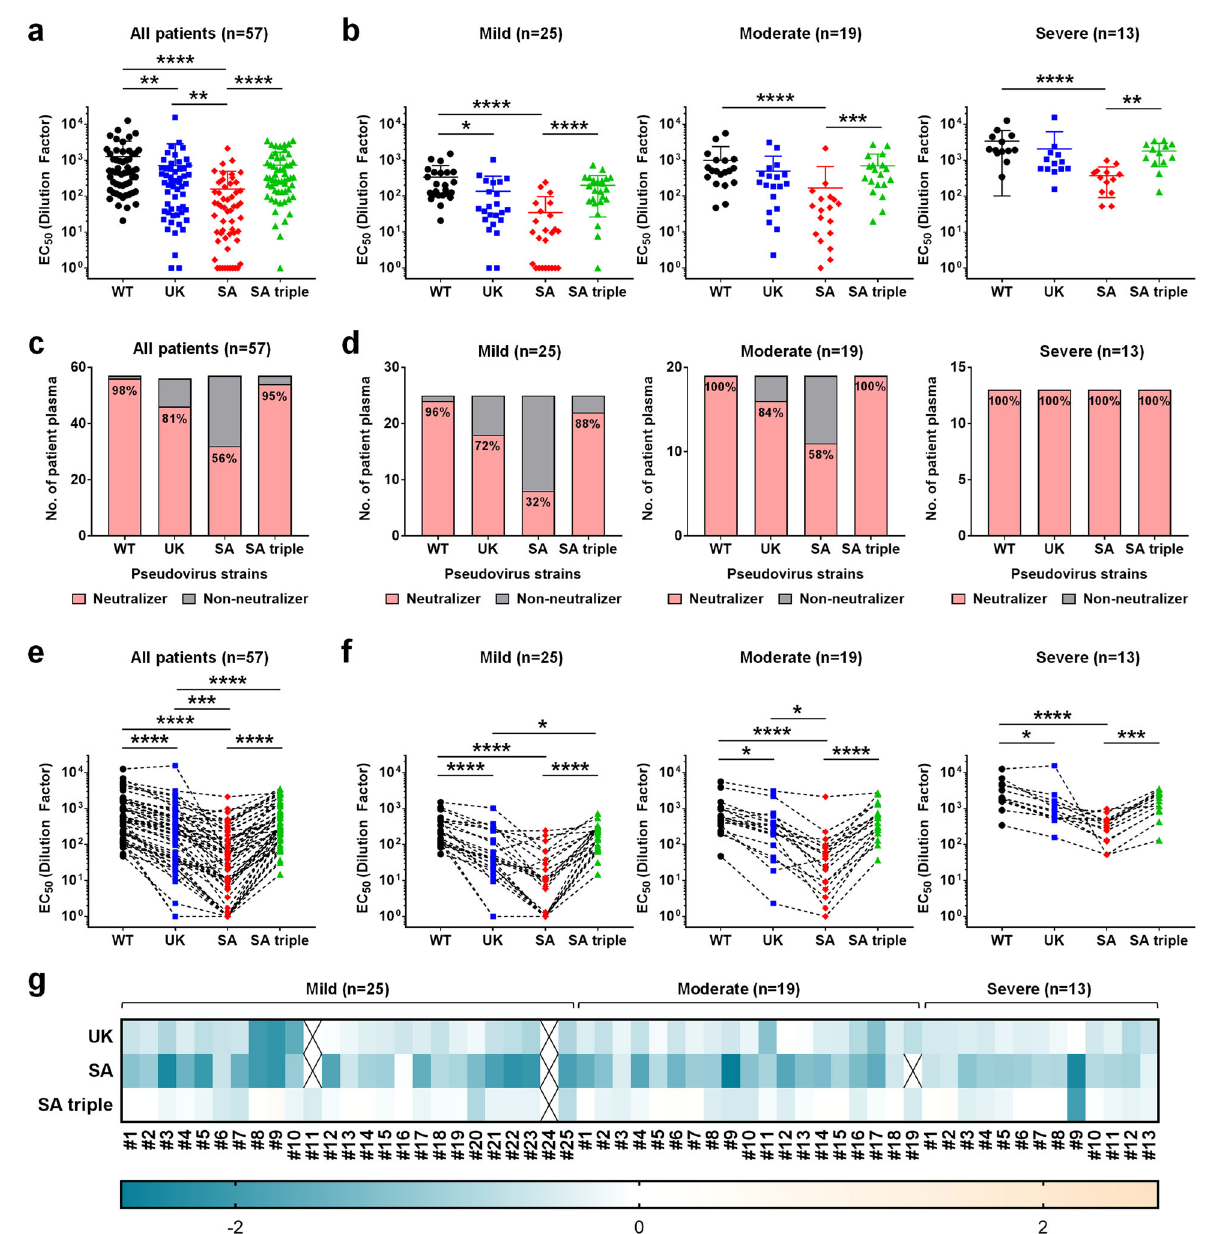
Fig. 2 Pseudovirus neutralization pro fi les of 57 COVID-19 convalescent plasma samples. Anti-SARS-CoV-2 neutralizing antibodies from 57 COVID-19 patients during the SARS-CoV-2 outbreak in Singapore were assessed using pseudovirus expressing SARS-CoV-2 Spike glycoprotein of either the original Wuhan strain (WT), UK strain B.1.1.7 (UK), SA strain B.1.351 (SA), and SA triple mutant K417N/E484K/N501Y (SA triple). All EC 50 values of neutralization were calculated by variable slope four-parameter nonlinear regression model using Graphpad PRISM 7 Software with top and bottom constraints set at 100 and 0% respectively. a , b Dot plots of EC 50 values of neutralization against WT (black circles), UK (blue squares), SA (red diamonds), and SA triple (green triangles) pseudoviruses from all 57 COVID-19 patients ( a ) or presented in three different severity groups of mild ( n = 25), moderate ( n = 19), and severe ( n = 13) ( b ). Statistical analysis was carried out to compare any two different pseudoviruses using Kruskal – Wallis tests followed by post hoc Dunn ’ s multiple comparisons tests (* P ≤ 0.05, ** P ≤ 0.01, *** P ≤ 0.001, **** P ≤ 0.0001). c , d Each individual patient sample was arbitrarily de fi ned as a “ Neutralizer ” (pink bar) if the neutralizing EC 50 is equal to or bigger than 20 (dilution factor) or “ Non-neutralizer ” (gray bar) if the neutralizing EC 50 is less than 20 (dilution factor). The numbers indicate the percentage of neutralizers. Distributions of “ Neutralizers ” and “ Non-neutralizers ” were presented across all 57 patients ( c ) or in each different disease severity groups ( d ). e , f Paired analysis of EC 50 values of neutralization was carried out using Friedman test followed by post hoc Dunn ’ s multiple comparisons tests (* P ≤ 0.05, *** P ≤ 0.001, **** P ≤ 0.0001). Comparison between WT (black circles), UK (blue squares), SA (red diamonds), and SA triple (green triangles) pseudoviruses from all 57 COVID-19 patients ( e ) or presented in three different severity groups of mild ( n = 25), moderate ( n = 19), and severe ( n = 13) ( f ). g Log 10 values of fold increase (positive value) or fold decrease (negative value) in neutralization EC 50 of UK, SA, and SA triple pseudoviruses, relative to the WT pseudovirus are presented as heat maps with darker colors implying greater changes. The samples were organized into three different severity groups of mild ( n = 25), moderate ( n = 19), and severe ( n = 13). Yellow, increase; Blue, reduction. An X indicates that the EC 50 value cannot be